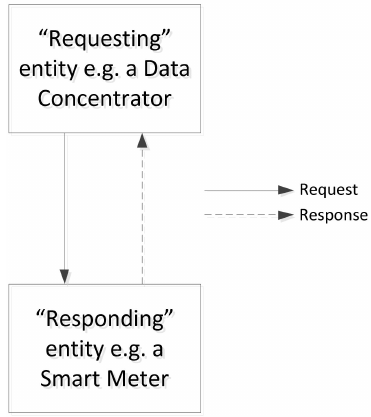
Figure 2. Dynamics of interaction between two components of